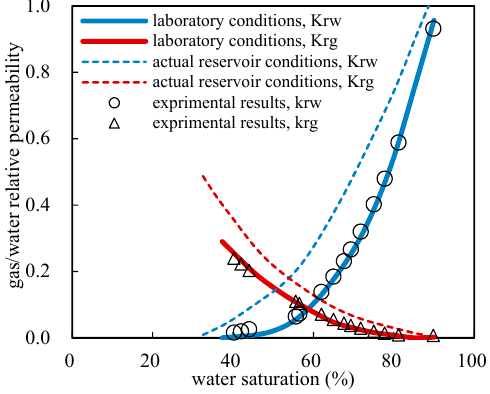
Figure 17. Gas/water relative permeability curves of core 35 #.